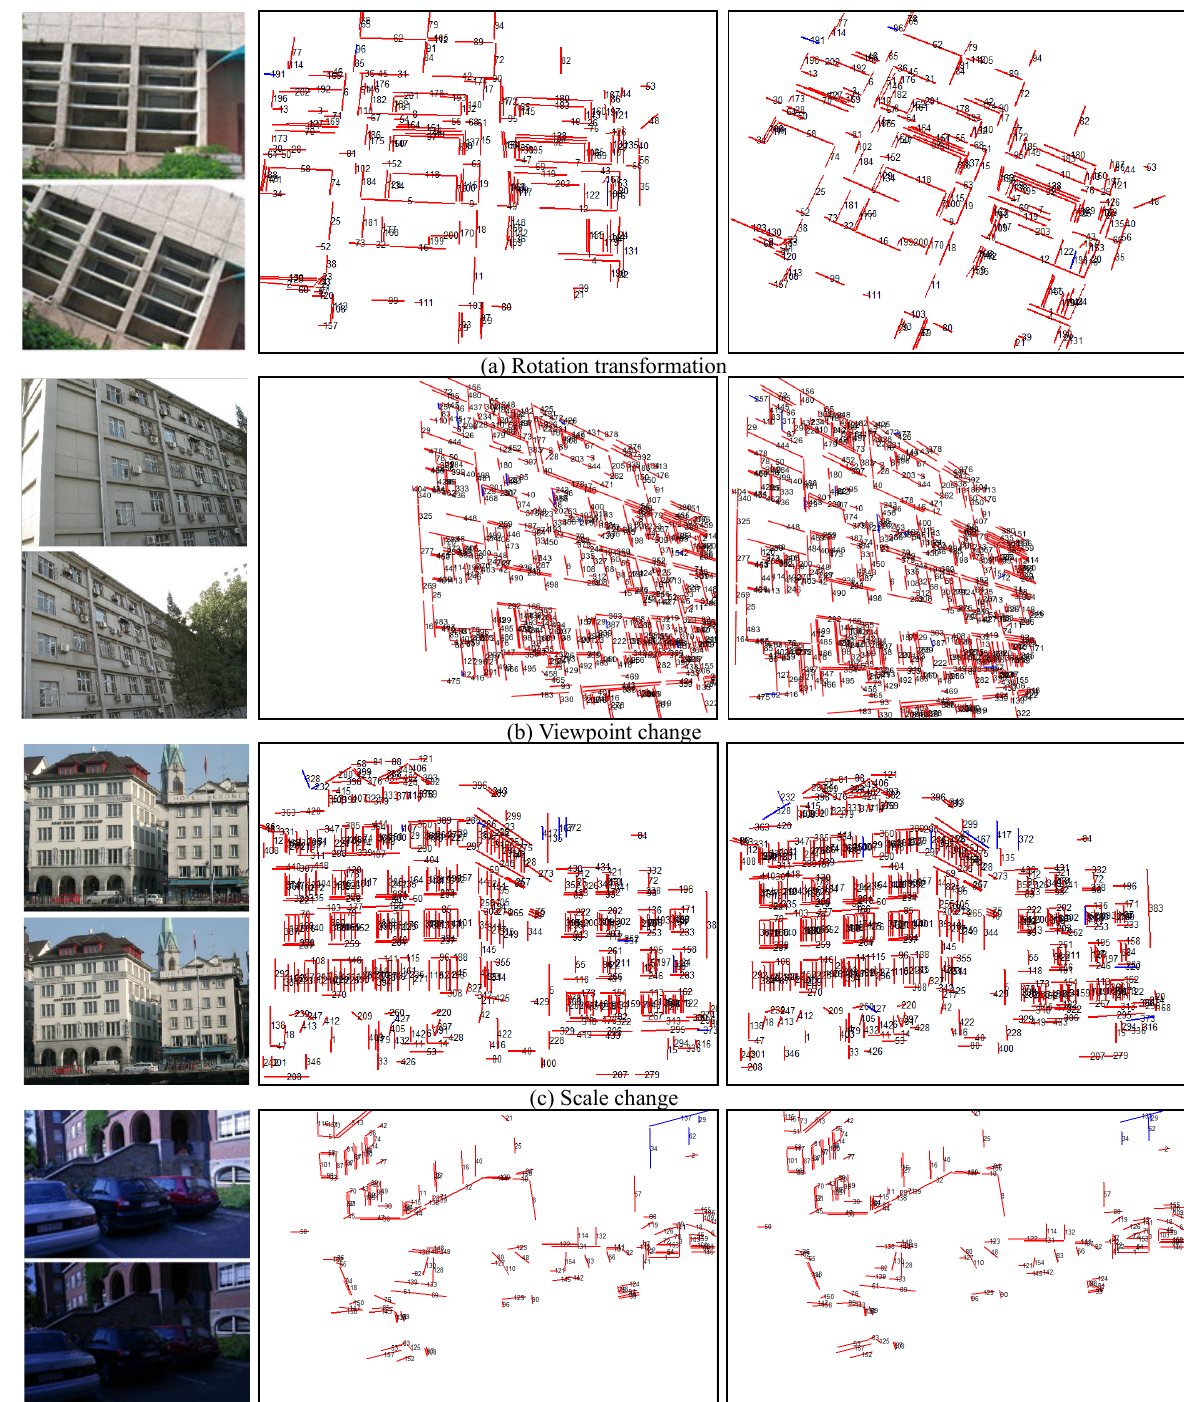
Figure 6. Matching results of our algorithm for different image